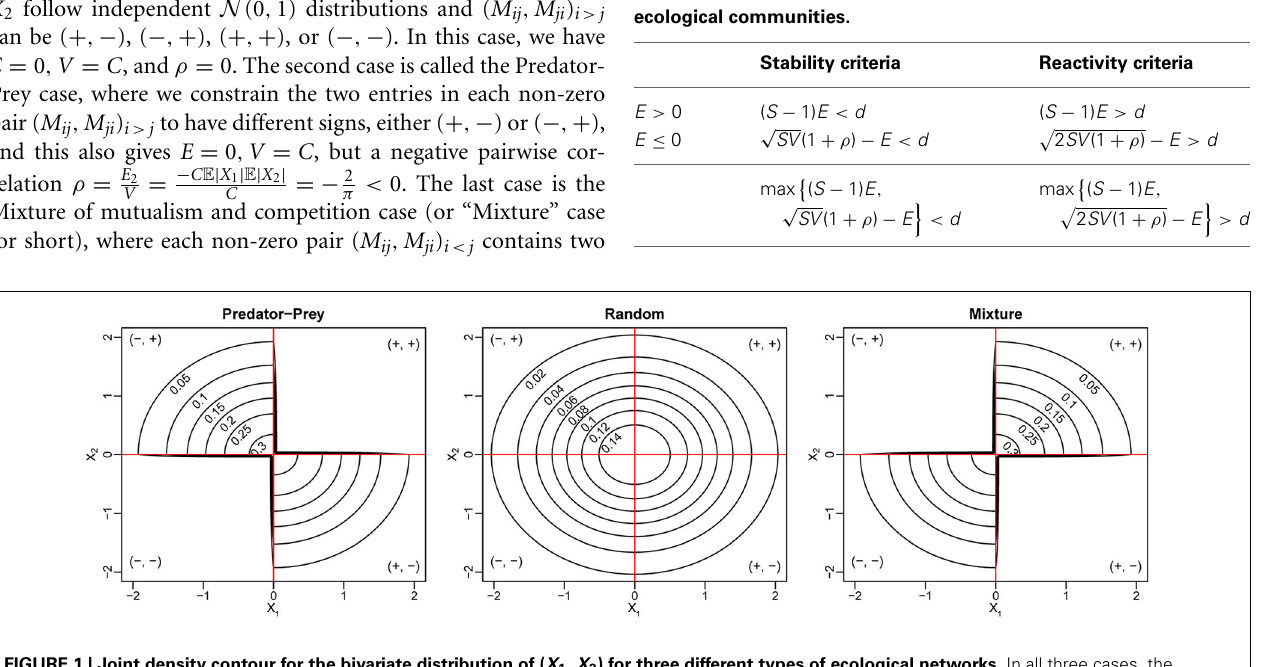
Frontiers in Ecology and Evolution | Population